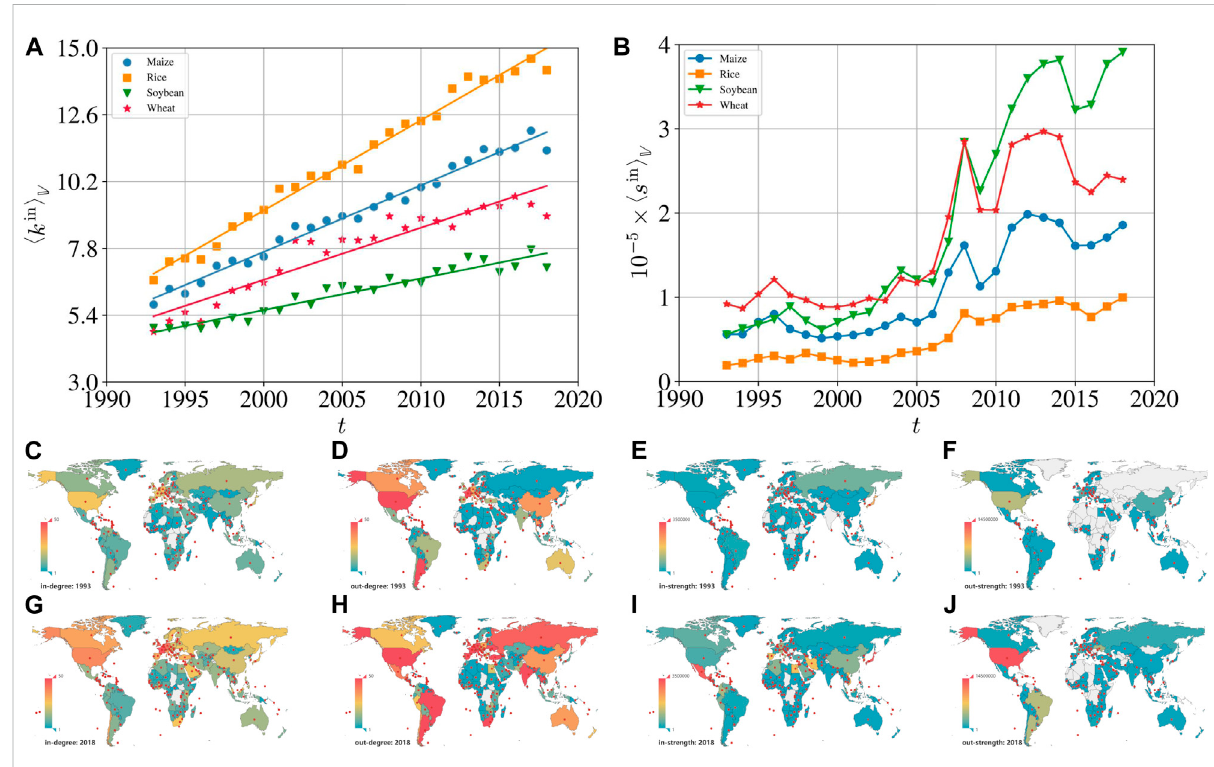
Yearly evolution of the degrees and the strengths of the four iCTNs from 1993 to 2018. The graphs in the fi rst row (A – B) respectively show the evolutionoftheaveragein-degreeandtheaveragein-strengthfrom1993to2018.Curvesindifferentcolorscorrespondtodifferentcrops.Therows from middle to bottom show the distributions of the degrees and the strengths of the international maize trade network in 1993 and in 2018. The middlerowshowstheglobalmapin1993: (C) Thedistributionofthein-degree; (D) thedistributionoftheout-degree; (E) thedistributionofthe in-strength; (F) the distribution of the out-strength. The bottom row shows the global map in 2018: (G) The distribution of the in-degree; (H) the distribution of the out-degree; (I) the distribution of the in-strength; (J) the distribution of the